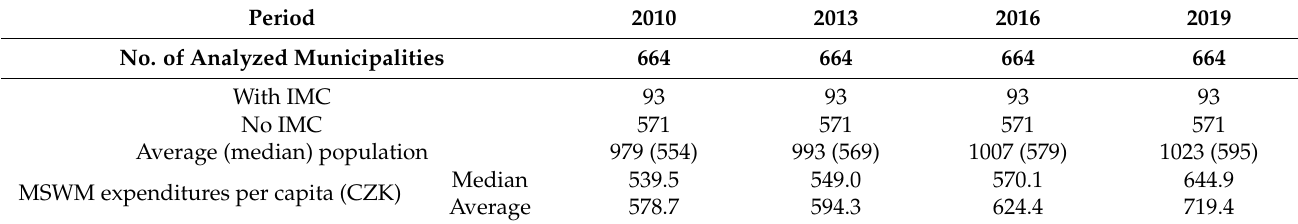
Table 2. Analyzed group of municipalities, distribution of intermunicipal cooperation (IMC) presence, population, average and median municipal solid waste management (MSWM) expenditures per capita, 664 units, selected years 2010–2019.